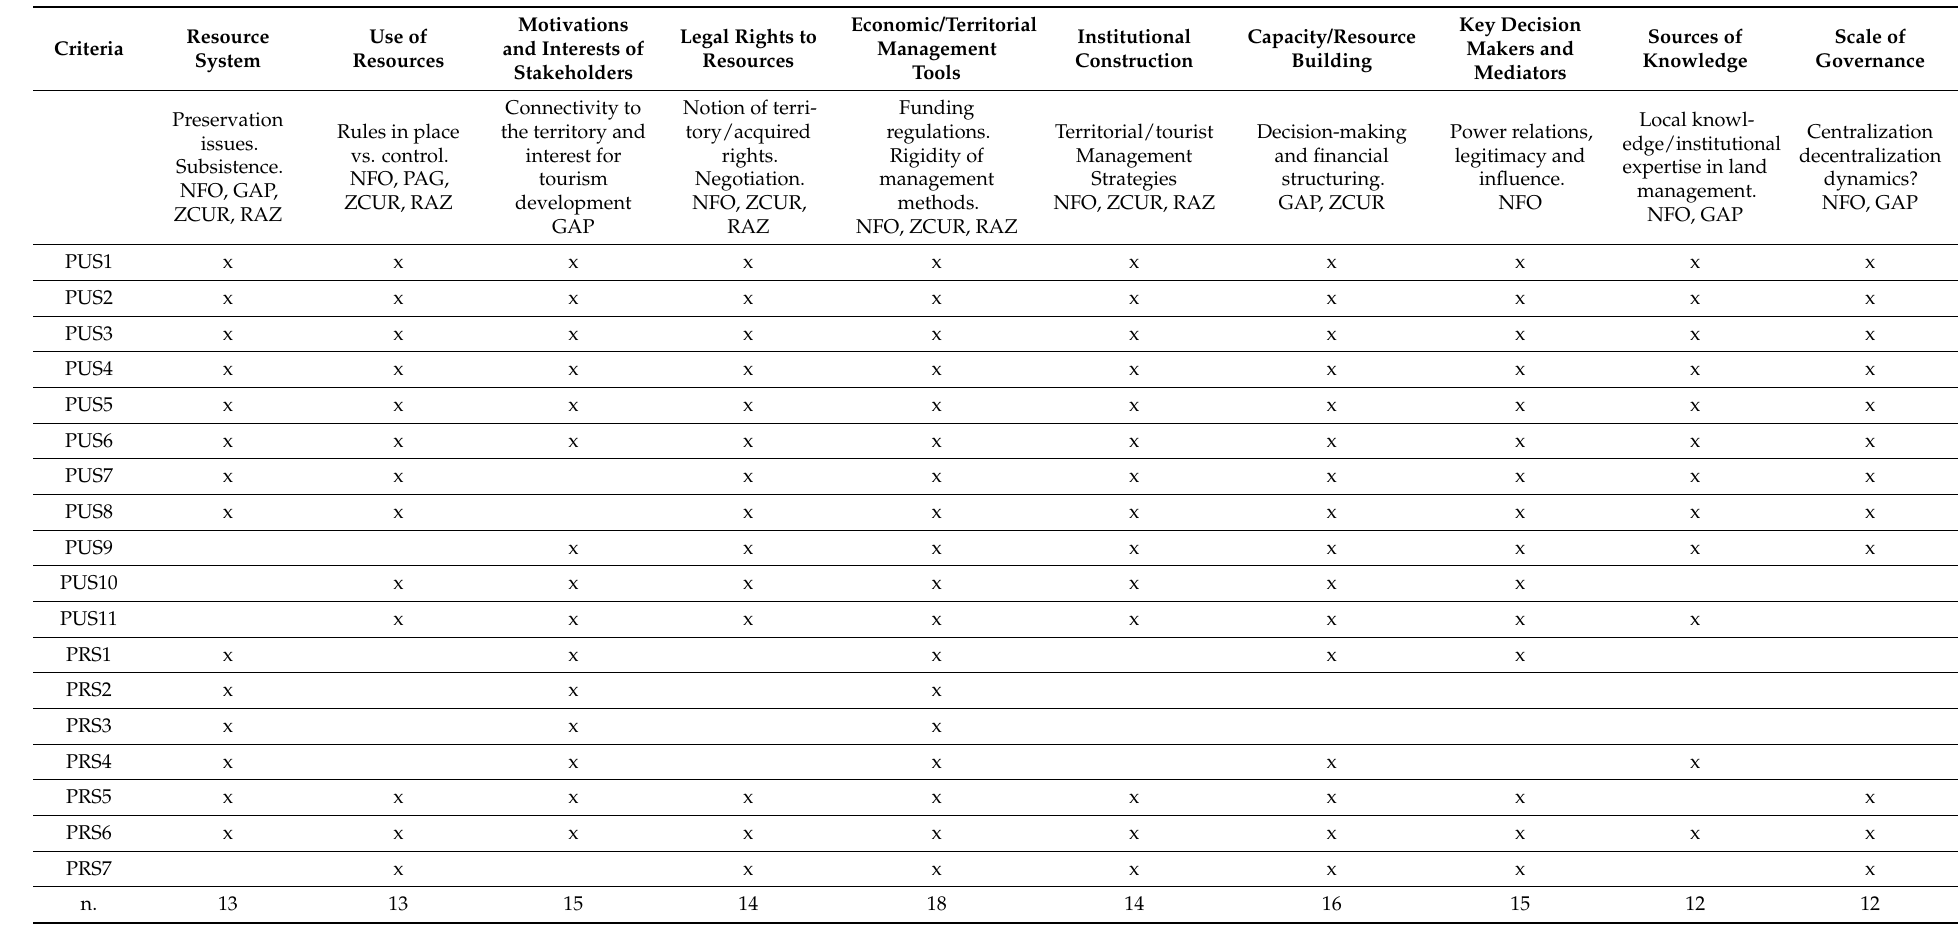
Table 3. Criteria and the related questions identified as important by